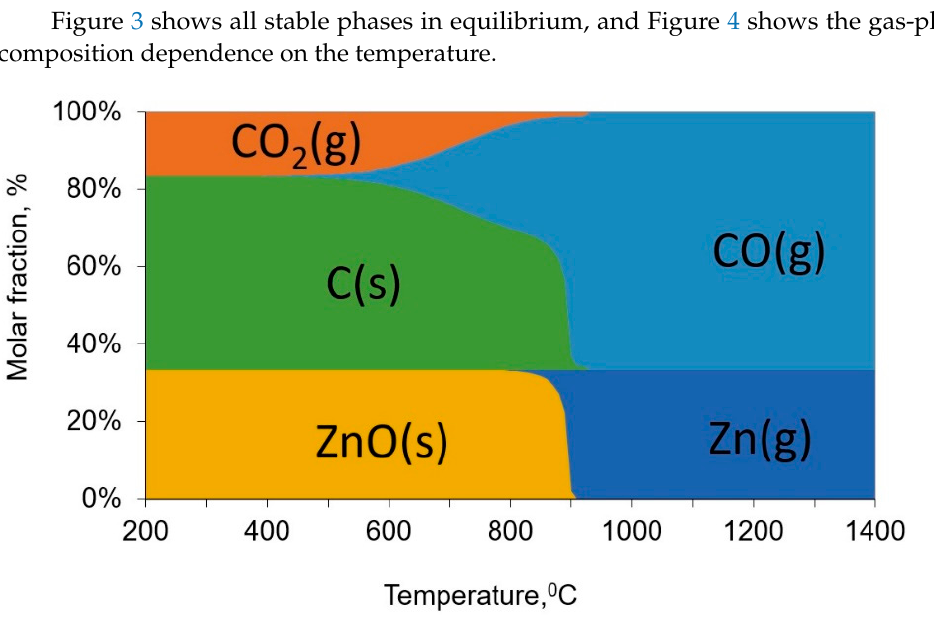
Figure 3. Equilibrium of all stable phases dependent upon the temperature.